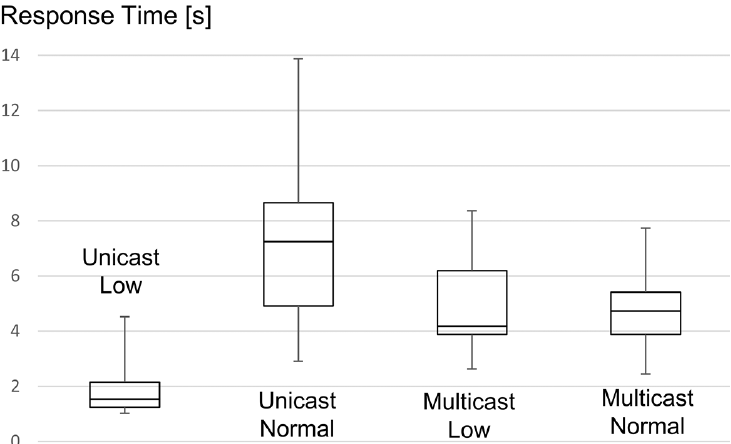
Figure 16. Entity response times for both unicast and multicast group communication in a real-life environment under low and normal network usage. Unicast reliability is achieved by exponential retransmissions and leads to a large increase in the response